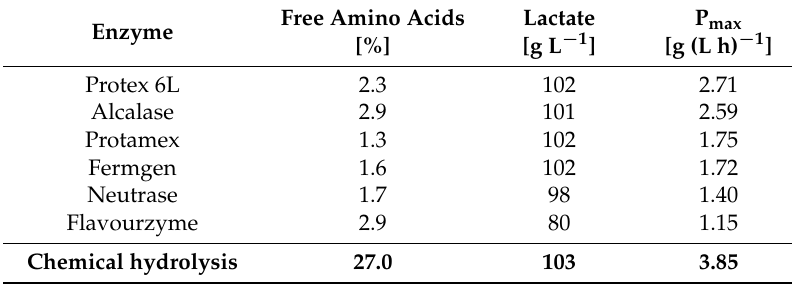
Table 1. Hydrolysis of rapeseed meal with different proteases, resulting free amino nitrogen content and the effect on the cultivation of S. inulinus at 38 °C, 0 rpm.